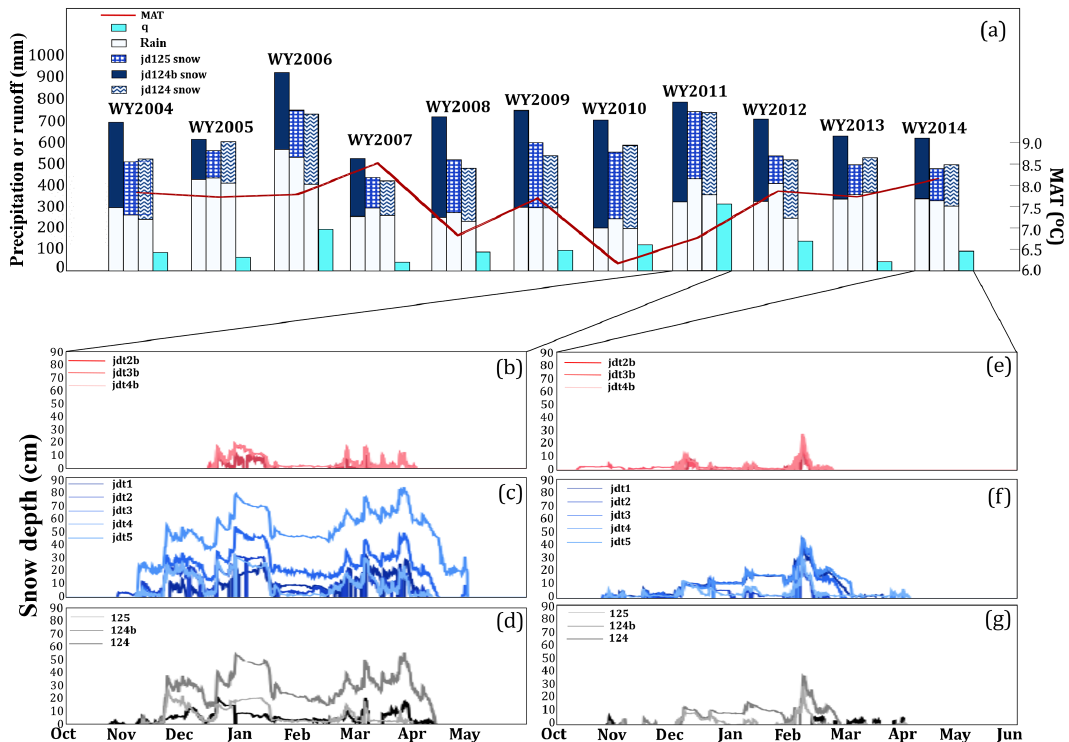
Figure 3. (a) Cumulative annual precipitation from sites 125, 124b, and 125 and cumulative runoff ( q ) as measured at the JD outlet and mean annual temperature (MAT) based on stations 124 and 125 which are collecting data over the entire 11 WY. That the three precipitation sites are similar in WY2005 and WY2011 suggests warmer, less windy conditions. Streamflow ( q ) is specific discharge, or total volumetric streamflow ( Q ) normalized by catchment area. (b–g) Snow depth in the JD for WY2011 (b–d) and WY2014 (e–g) . Panels (b, e) show snow depth from sites on the south-facing slopes in red colors, (c, f) show snow depth on the north-facing slopes in blue colors, and (d, g) show snow depth from 125, 124b, and 124 in grayscale. Each legend shows sites ordered from the lowest to highest elevations, with brighter tones at lower elevations. Snow depths increase inconsistently with increasing elevations due to wind scour from exposed sites and accumulation in sheltered areas. Gaps due to instrument failure are seen as breaks in the continuous time series line in some